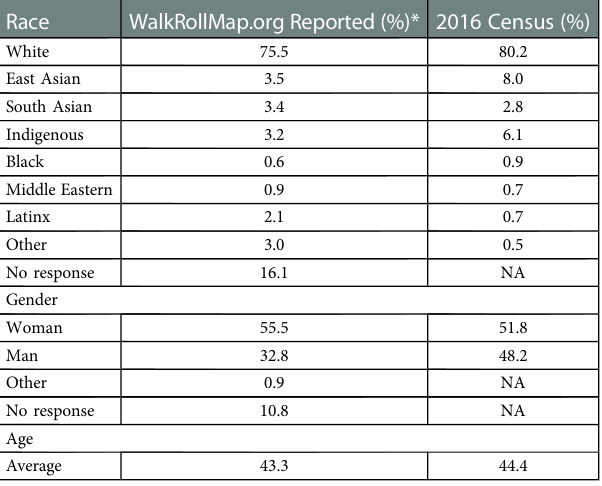
TABLE 2 Comparison of walkRollMap.org self-reported age, gender, and race with the 2016 Canadian census for the capital regional district (BC).